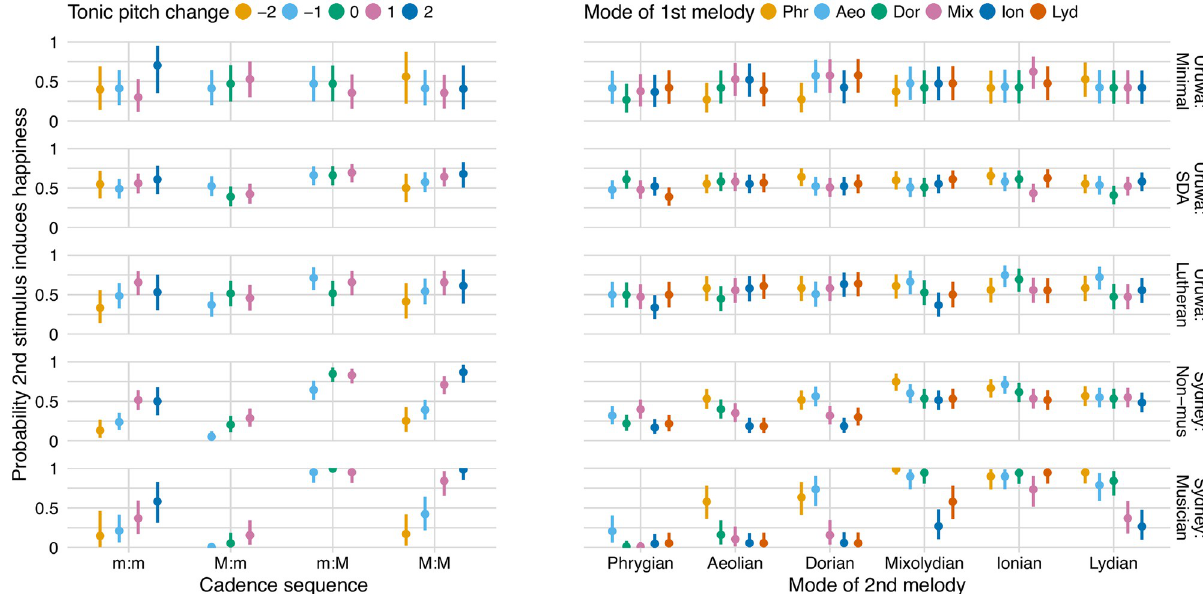
Fig 1. Visualizations of the effects of standard musicological categorizations across the five groups of participants. For each pair of cadences, the effects produced by their cadence sequence and their tonics’ semitone pitch difference; e.g., a C minor cadence followed by a B [ major cadence has the cadence sequence ‘m:M’ and a tonic pitch change of − 2 semitones. For each pair of melodies, the effect of their mode sequence (the Phrygian mode has the lowest mean pitch followed by Æolian, followed by Dorian, and so forth, up to Lydian, which has the highest mean pitch). The bars show the descriptive models’ 95% credibility